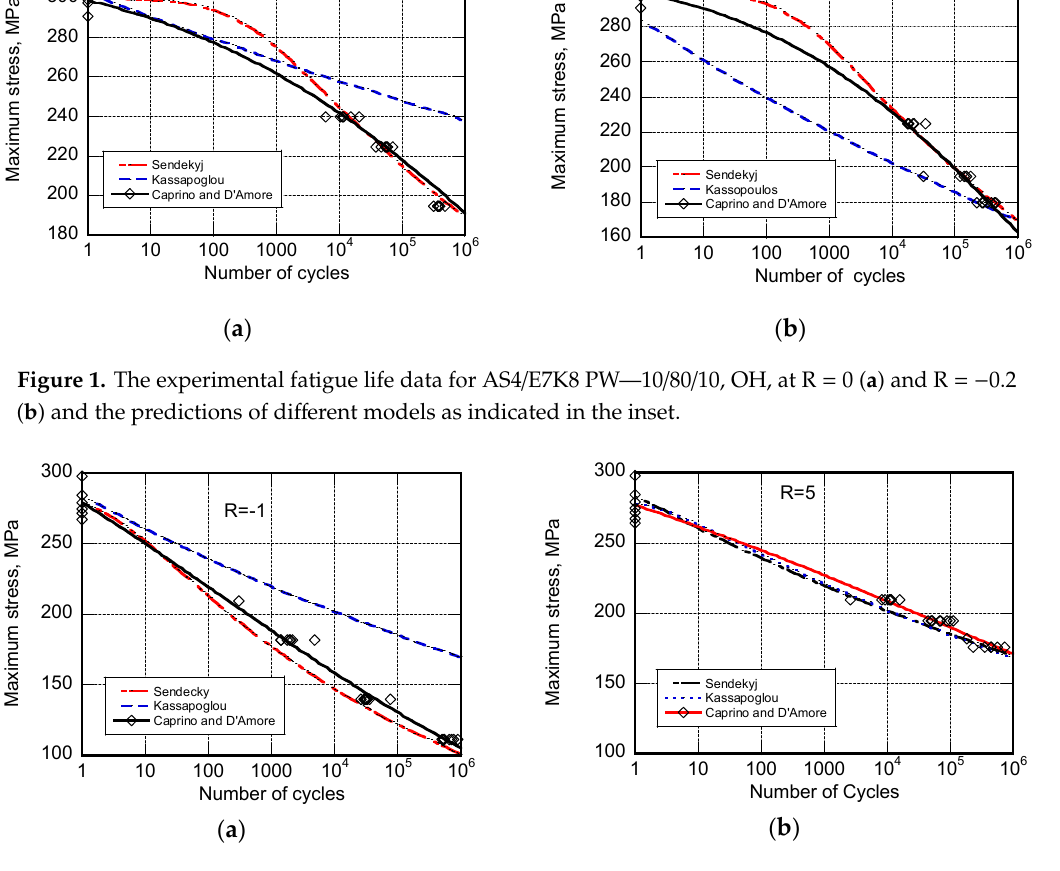
Figure 2. The experimental fatigue life data for AS4 / E7K8 PW—10 / 80 / 10, OH, at R = − 1 ( a ) and R = − 5 ( b ) and the predictions of di ff erent models as indicated in the